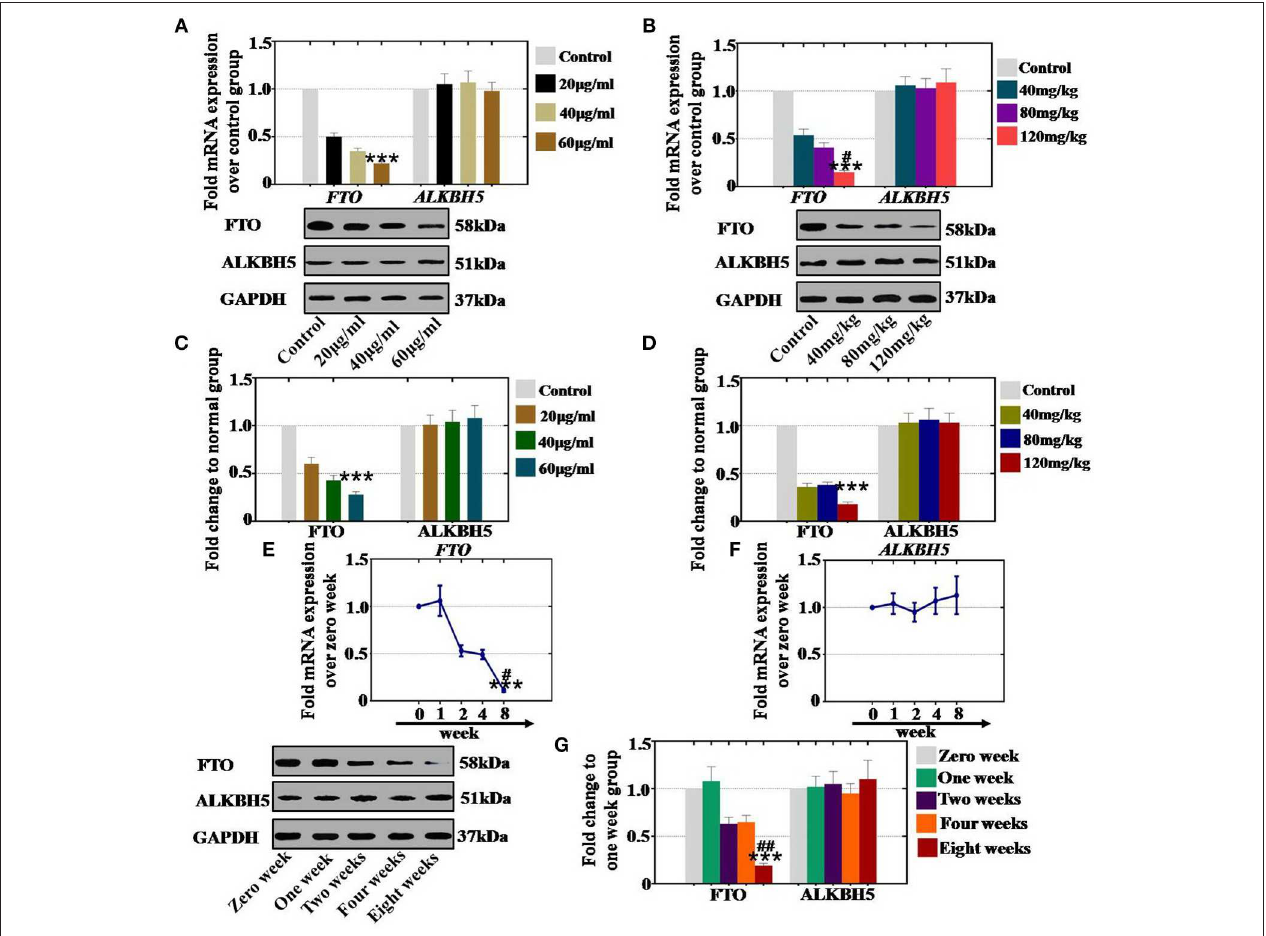
FIGURE 5 | Quantification, concentration- and time-dependence analysis of the RNA demethylase expression levels after CTX treatment in vivo and in vitro . (A) The mRNA expression levels of FTO and ALKBH5 in hGCs were determined after treatment with CTX at concentrations of 20, 40, and 60 µ g/ml. (B) The mRNA expression levels of FTO and ALKBH5 in mouse ovary were determined after treatment with 40, 80, and 120 mg/kg CTX. (C) The protein expression levels of FTO and ALKBH5 in hGCs were determined after treatment with CTX (20, 40, and 60 µ g/ml). (D) The protein expression levels of FTO and ALKBH5 in mouse ovary were determined after treatment with 40, 80, 120 mg/kg CTX. (E) The mRNA expression levels of FTO and ALKBH5 in hGCs were determined after treatment with 60 µ g/ml CTX from 0 to 8 weeks. (F) The mRNA expression levels of FTO and ALKBH5 in hGCs were tested after treatment with 120 mg/kg CTX from 0 to 8 weeks. (G) The protein expression levels of FTO and ALKBH5 in mouse ovary were tested after treatment with 120 mg/kg CTX from 0 to 8 weeks. The error bars indicate SD; *** p < 0.001 (compared with the control group); # p < 0.05; ## p < 0.01 [compared with the 80mg/kg CTX concentration group in (B) , compared with the four weeks group in (E,G) ].